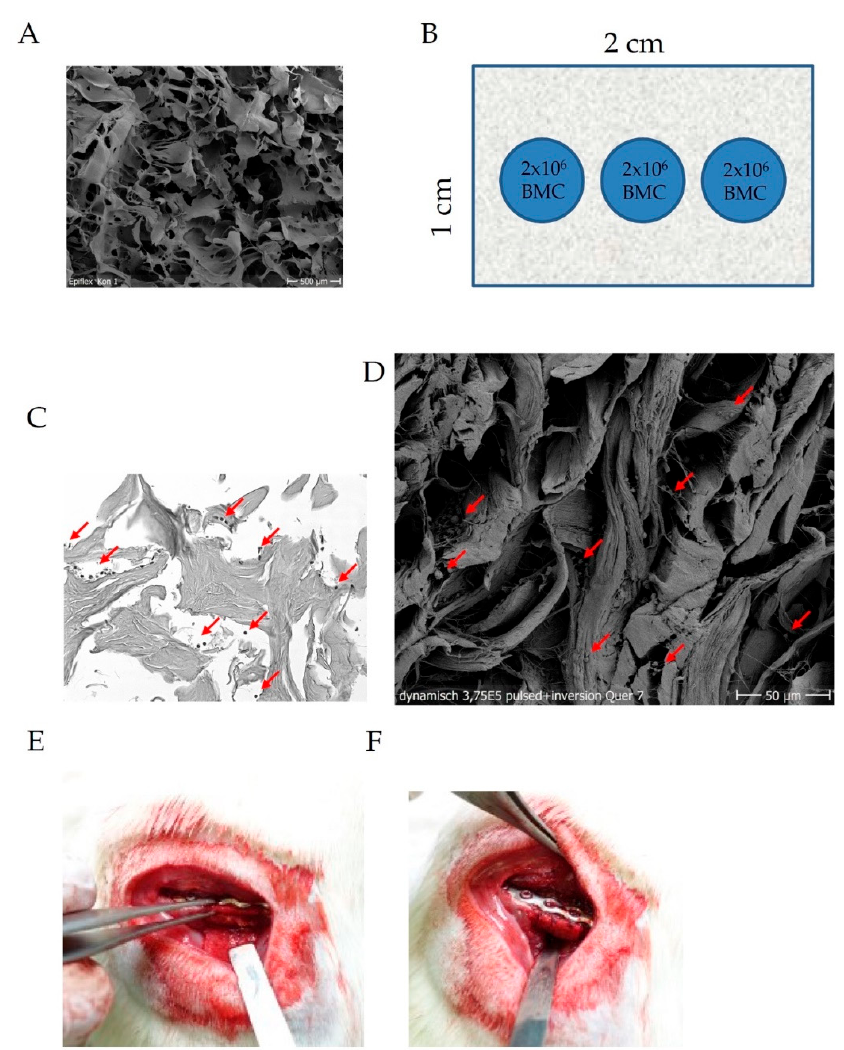
Figure 1. Internal structure of the decellularized dermis ( A ), cell seeding scheme ( B ), histological (HE- stain) and SEM proof of BMC (red arrows), within internal structures of the dermis ( C,D ) and fitting, filling and suturing of the replacement membrane ( E,F ).